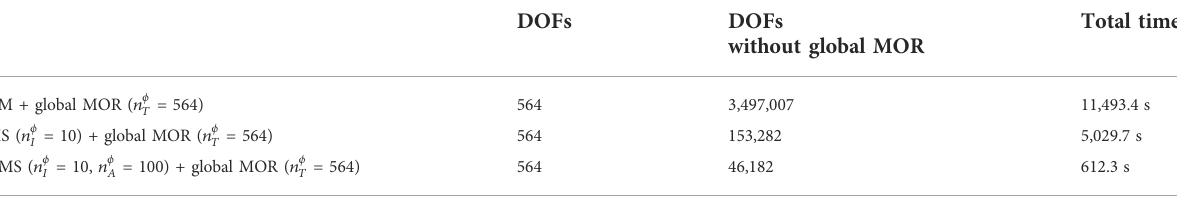
TABLE 6 Overview of FOM, BMS and GBMS UC based fi nite LRM plate model sizes for the clamped fi nite plate assembly of 15 × 15 UCs and total computational times required to calculate the STL results of Figure